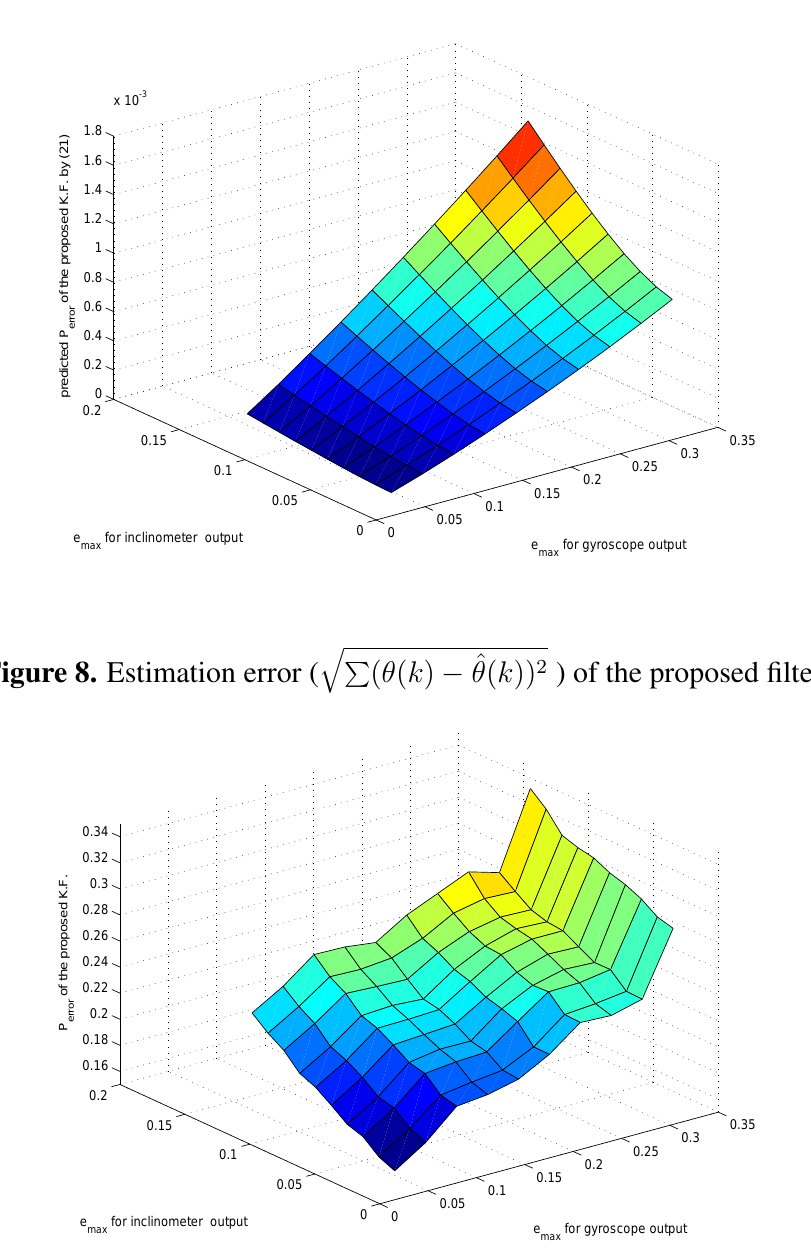
Figure 7. Predicted estimation error ( ¯ P ) of the proposed filter.